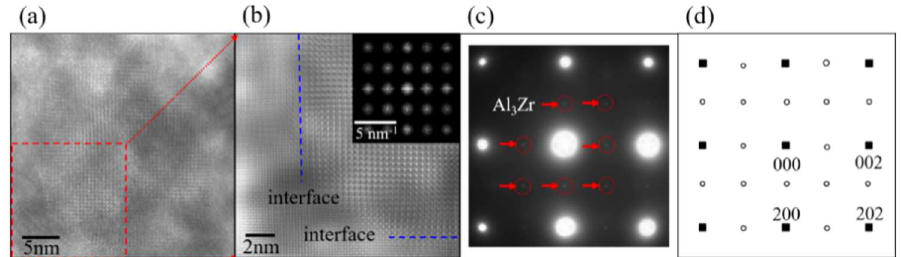
Figure 2. HRTEM and SAED images of Al 3 Zr in Al matrix ([100] zone axis). ( a ) HRTEM image of Al 3 Zr in Al matrix; ( b ) enlarged micrograph of Al 3 Zr in red frame of ( a ), with its fast Fourier transformation (FFT) as inset, where blue dashes present the major interfaces between particle and matrix; ( c ) SAED pattern of ( a ); ( d ) schematic representation of SAED pattern with projection along [100] zone axis, where small solid squares stand for Al matrix, and small open circles represent Al 3 Zr.